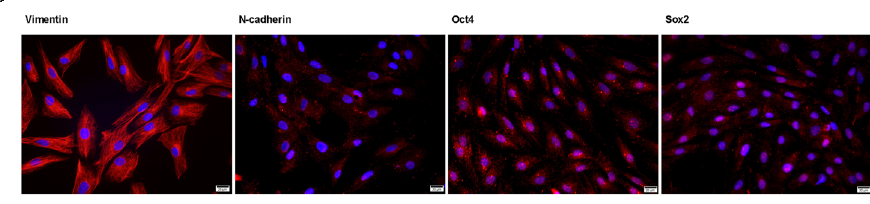
Fig. 4 Molecular characterization of limbal niche cells (LNCs). LNCs of passage 3 stained positive for vimentin, N-cadherin, Oct4, and Sox2. Scale bars: 100 μ